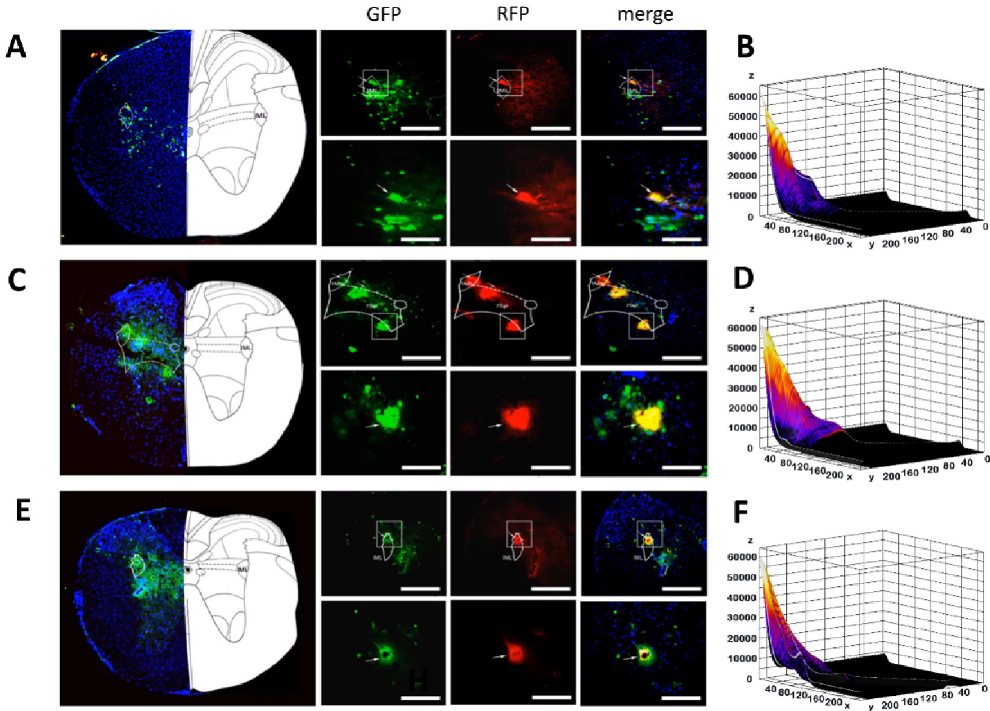
Fig 5. Common labeling in the spinal cord. A) Upper, PRV531 (green) neurons co-labeled with PRV724 (red) in the IML (T2) (scale bar, 100 um). Lower, magnification images of the area outlined by the white box (scale bar, 50 um). B) Colocalization analysis of neurons co-labeled in the IML (T2). C) Upper, PRV531 (green) neurons co-labeled with PRV724 (red) in the IML, 7Sp (T3) (scale bar, 100 um). Lower, magnification images of the area outlined by the white box (scale bar, 50 um). D) Colocalization analysis of neurons co-labeled in the IML, 7Sp (T2). E) Upper, PRV531 (green) neurons co- labeled with PRV724 (red) in the IML (T4) (scale bar, 100 um). Lower, magnification images of the area outlined by the white box (scale bar, 50 um). F) Colocalization analysis of neurons co-labeled in the IML (T4). The white arrows show the neural of colocalization fluorescence labeling; Yellow fluorescence shows colocalization of green and red fluorescence; IML, intermediolateral column; 7Sp, lamina 7 of the spinal gray; All data are presented as the mean ± SEM. ��� P < 0.001, �� P < 0.01, � P <